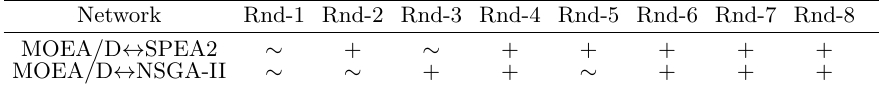
Table 3: Result of t